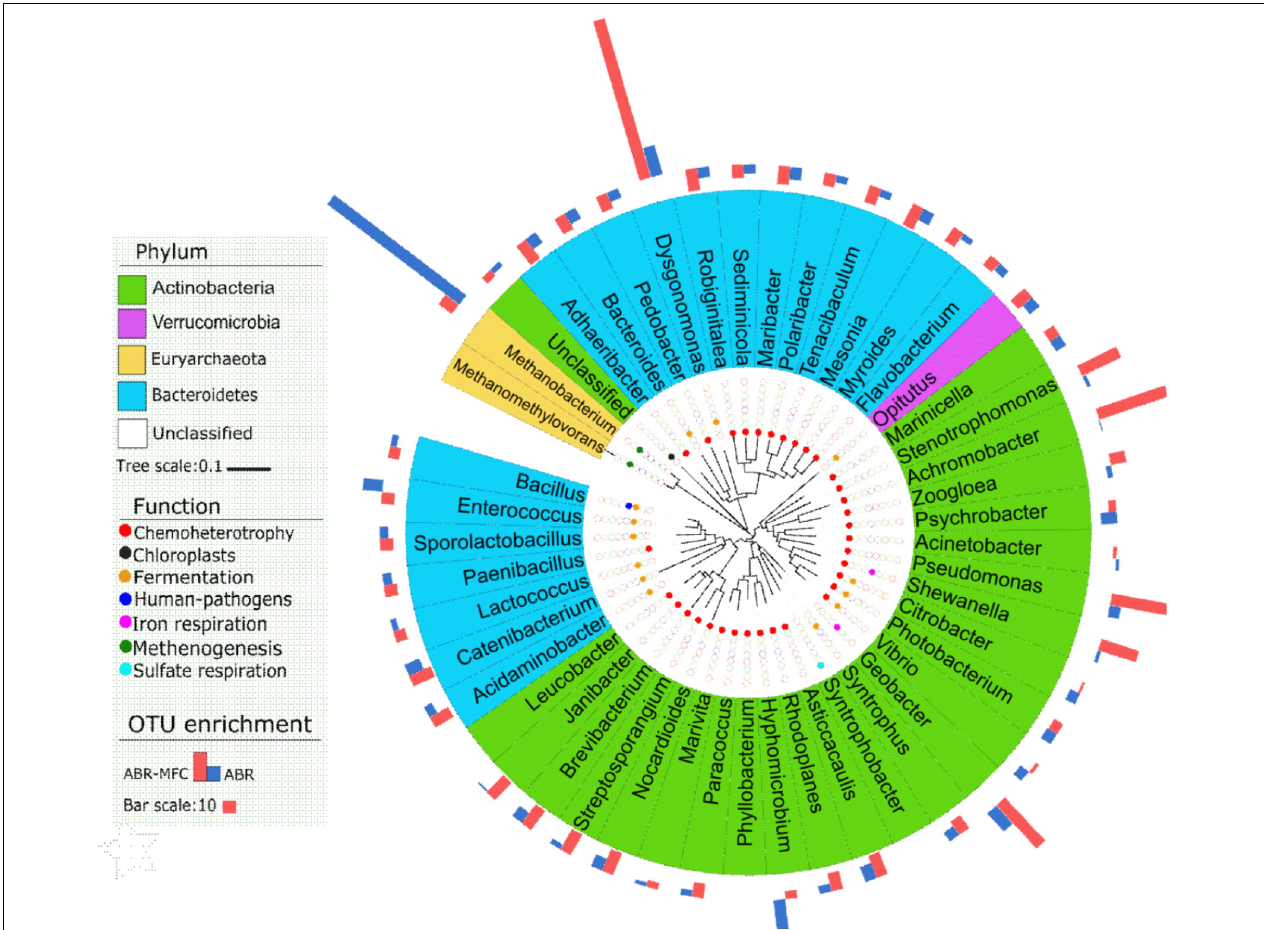
FIGURE 6 | The genera with significantly different ( p < 0.05, n = 3) OTU numbers among ABR, MFC-ABR and initial sludge and their annotated functions in FAPROTAX. The background color of each genus indicate its phylum. The circles filled with different colors indicate the functions of the corresponding genus. The bars in the outmost layer indicate the enhanced-fold of the genus in MFC-ABR and ABR, relative to the genus in initial